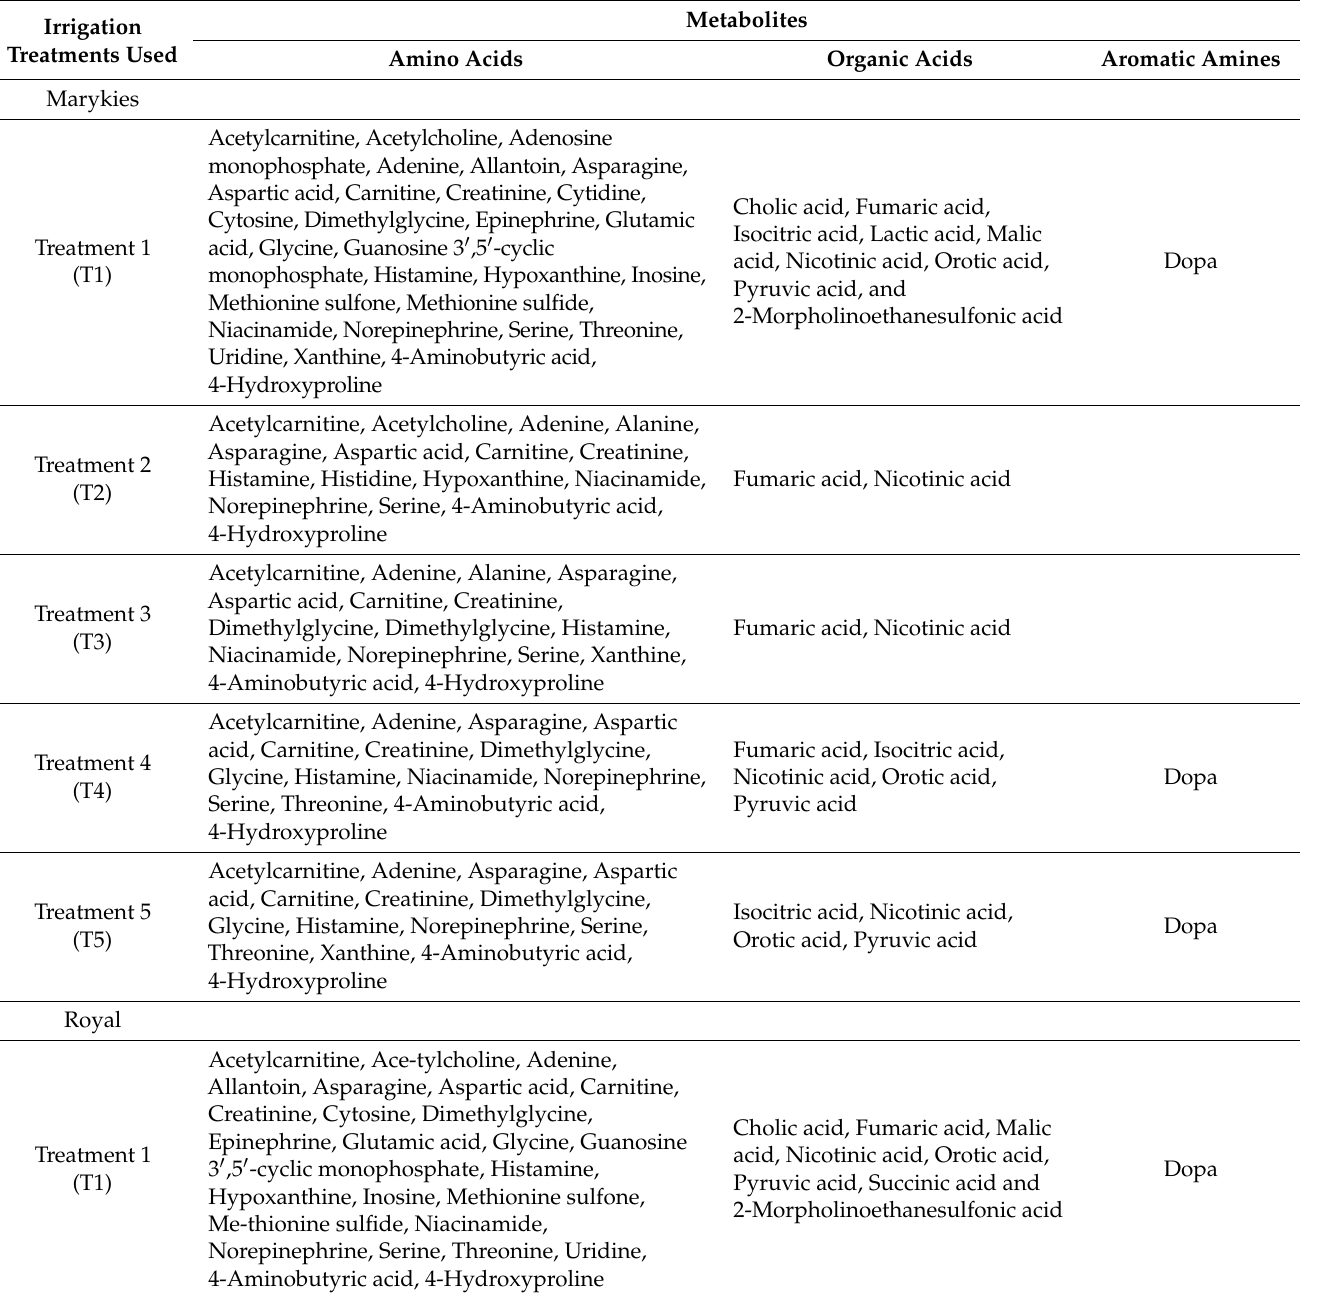
Table 1. Metabolites identified from a methanol tissue extract of potato